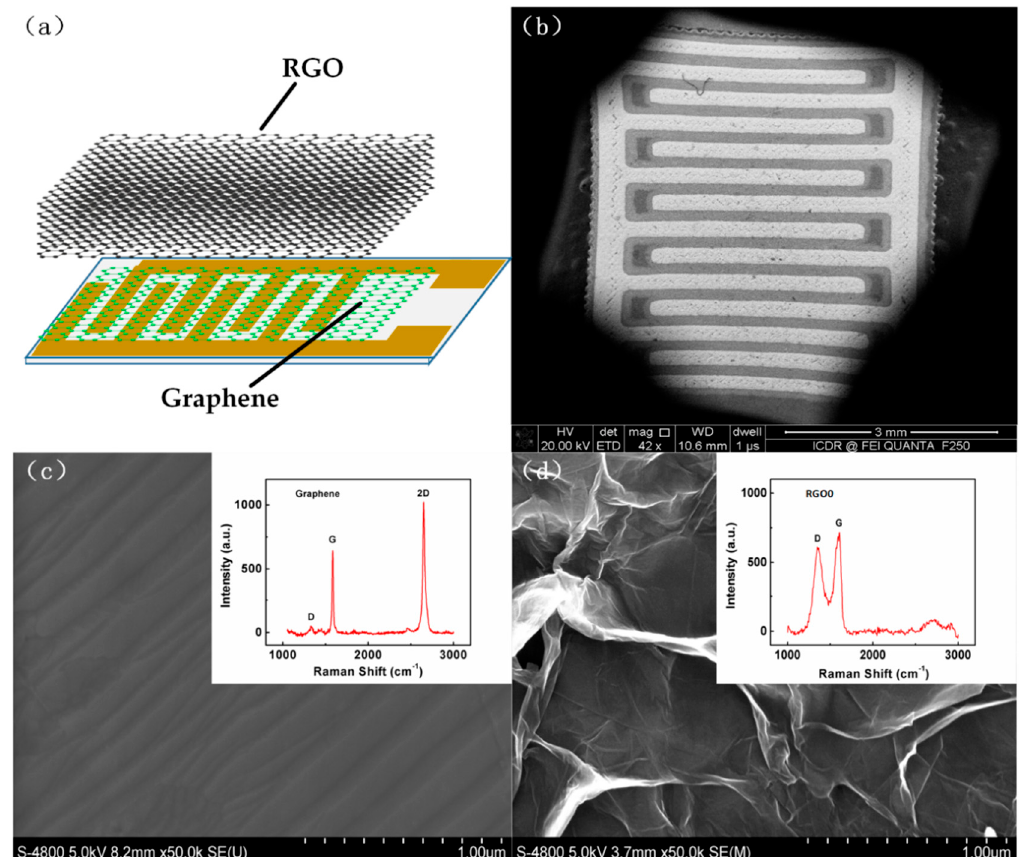
Figure 4. ( a ) Schematic diagram of RGO-Gr hybrids gas sensors; ( b ) SEM image of CVD Graphene on IDE electrode; SEM image and Raman spectra of the ( c ) graphene and ( d ) RGO0.